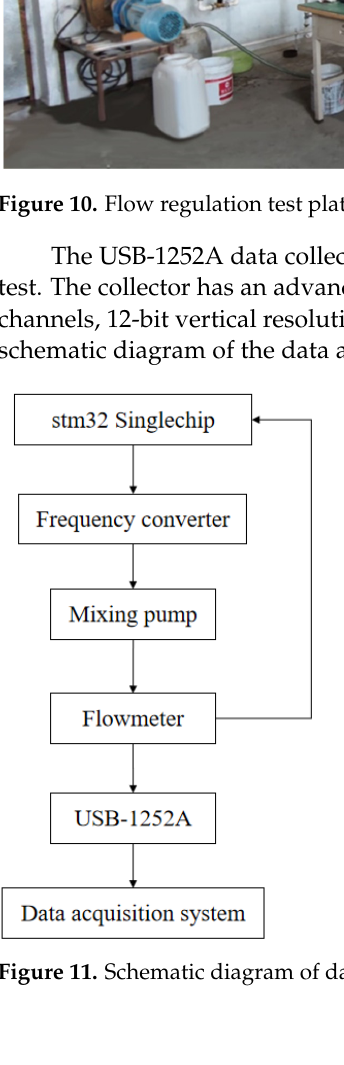
Figure 11. Schematic diagram of data acquisition and control system.